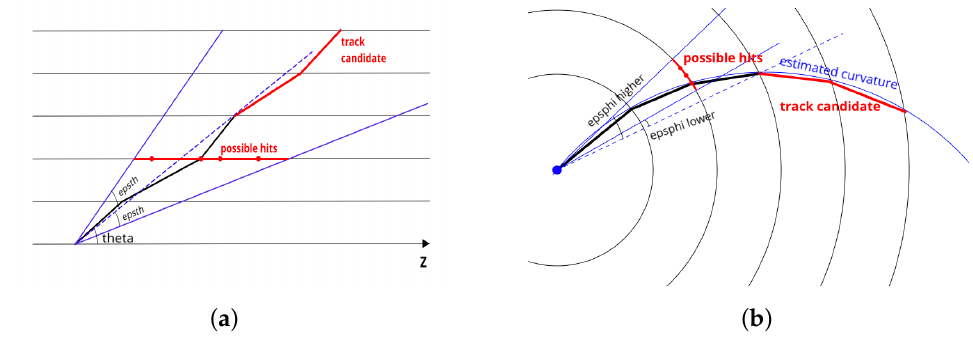
Figure 2. ( a ) Longitudinal projection scheme for a primary track. ( b ) Transverse projection scheme for a primary